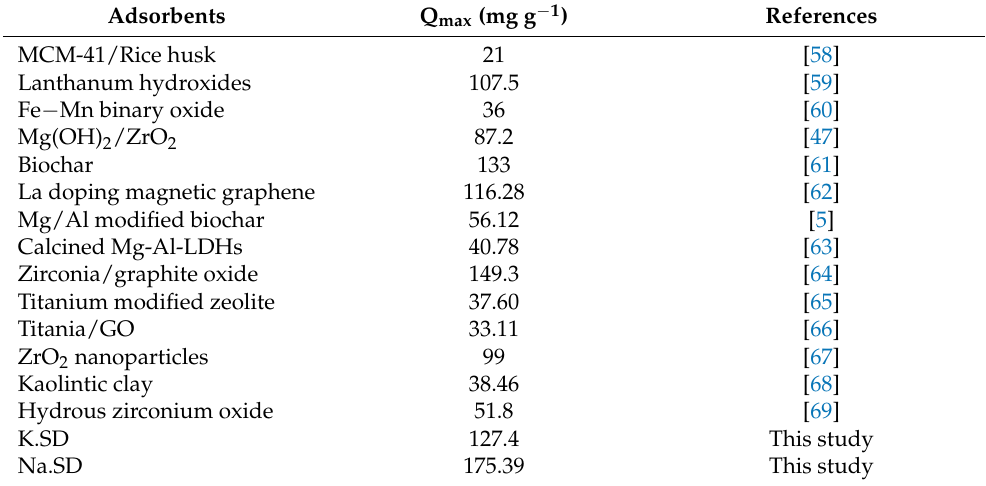
Table 6. The estimated PO 43 − sequestration capacities of K.SD and Na.SD as compared to other studied